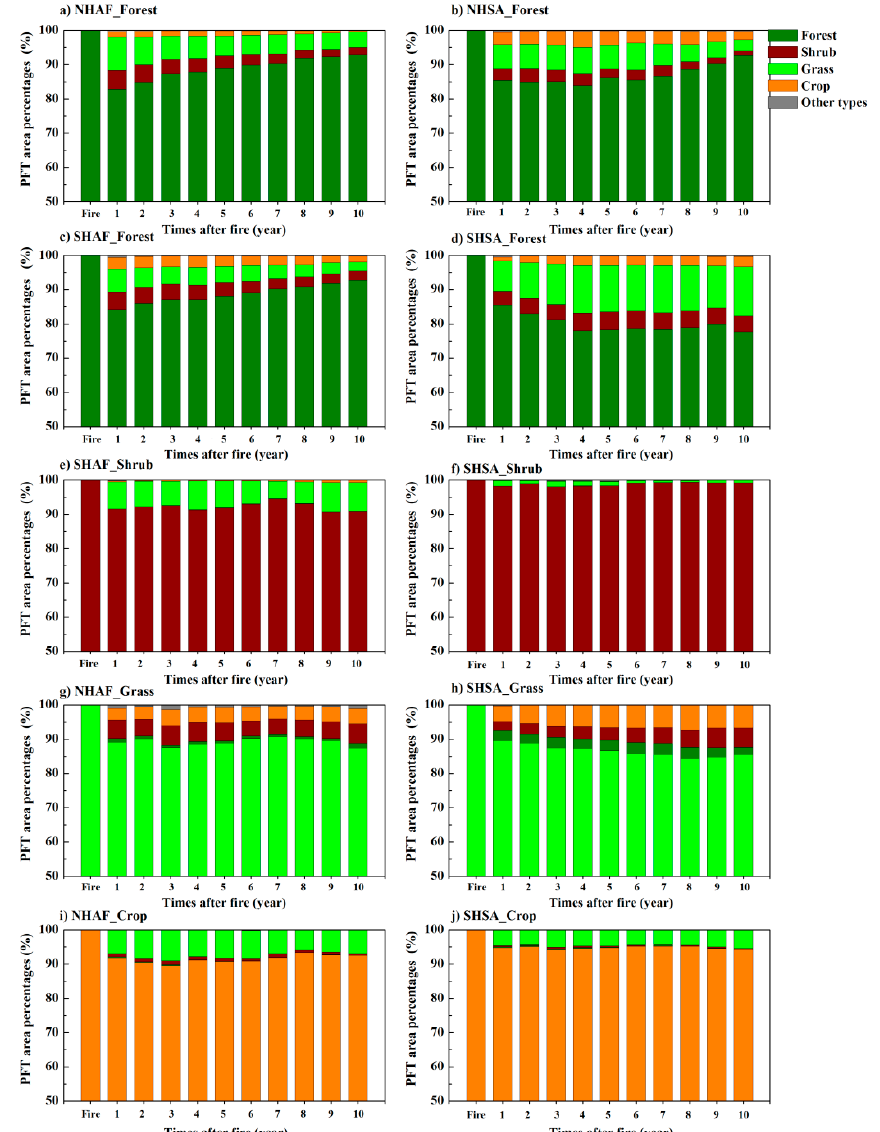
Figure 3. Land cover transitions (%) following fires in specific regions: Forest in Africa ( a , c ) and South America ( b , d ); shrub in Africa ( e ) and South America ( f) ; grass in Africa ( g ) and South America ( h ); crop in Africa ( i ) and South America ( j ). See Figure 1 for detailed information. The fitting equations for the forest fractions: NHAF_Forest: y = 1-0.183*exp( − t/10.2), R 2 = 0.981; SHAF_Forest: y = 1-0.169*exp( − t/12.8), R 2 = 0.979; NHSA_Forest: y = 1-0.174*exp( − t/18.4), R 2 = 0.667.